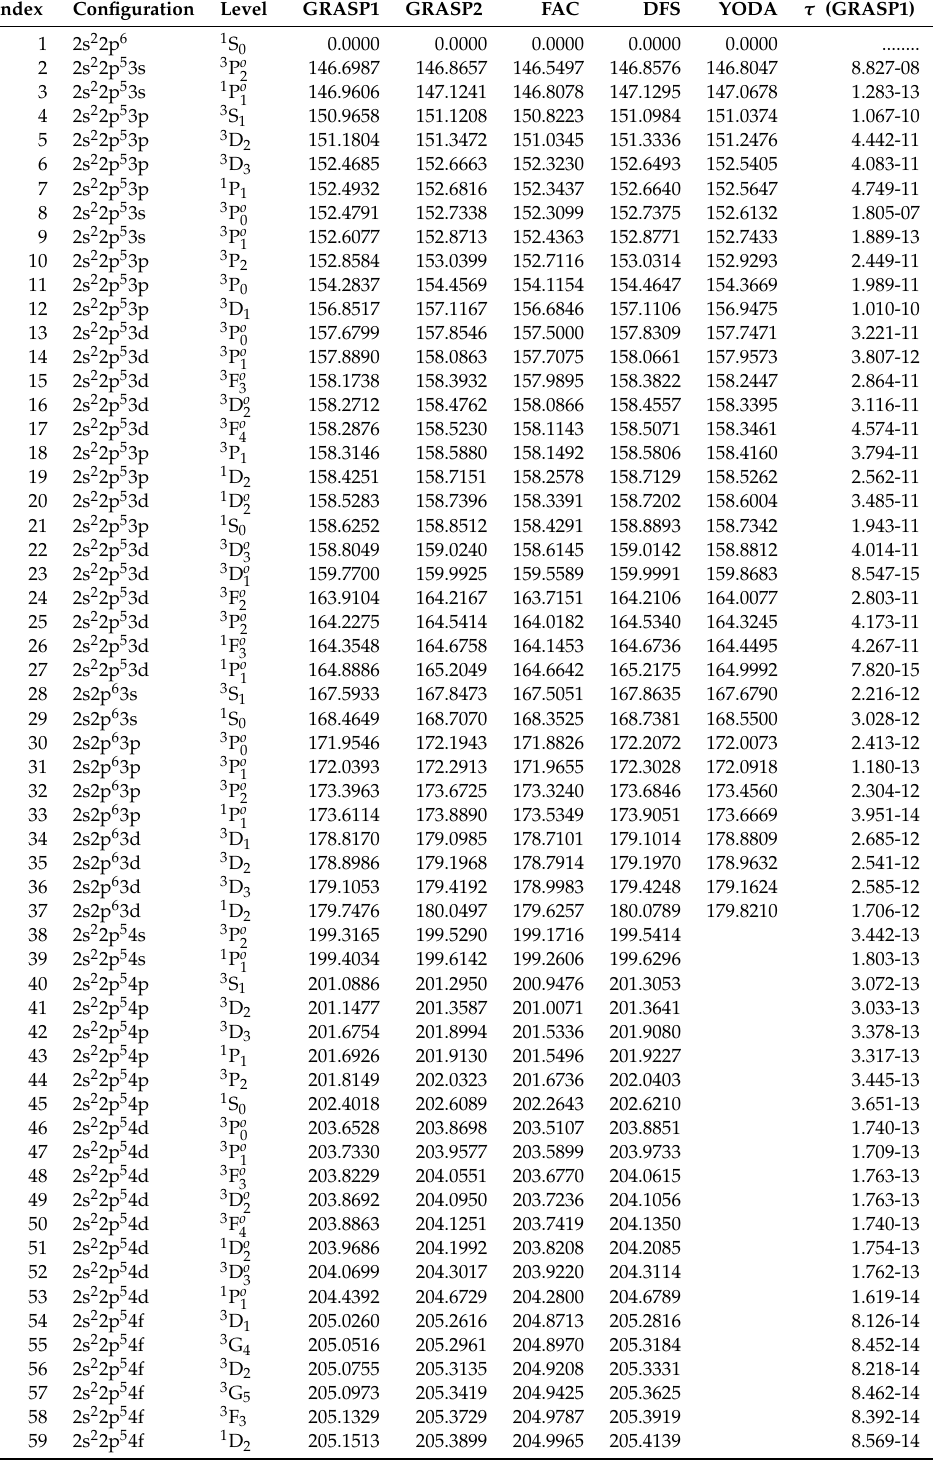
Table 4. Energies (in Ryd) and lifetimes ( τ , s) for the lowest 139 levels of Y XXX. a ± b ≡ a × 10 ± b